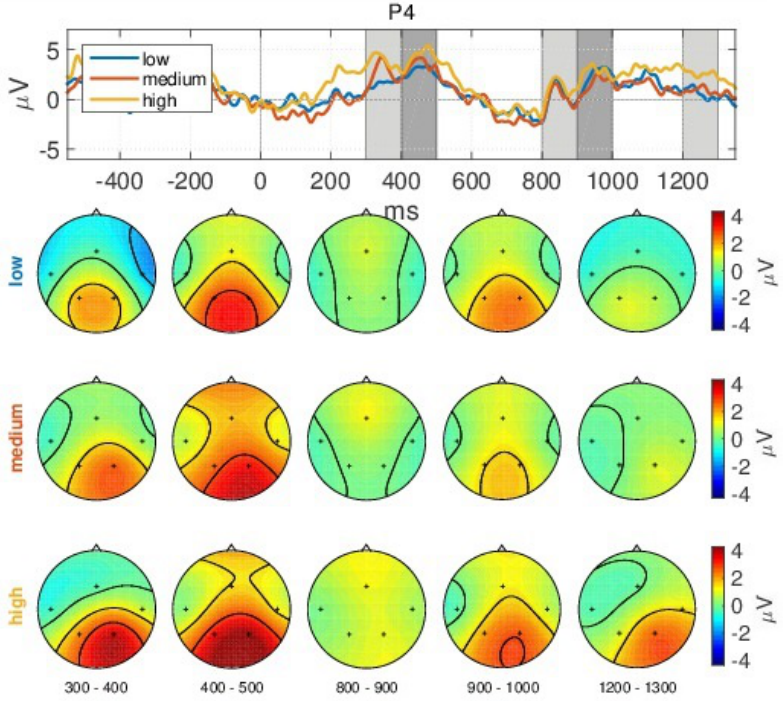
Figure 7. GA ERP for Nat images on three complexity levels according to CFD, at channel P4. ERPs vs. Participants